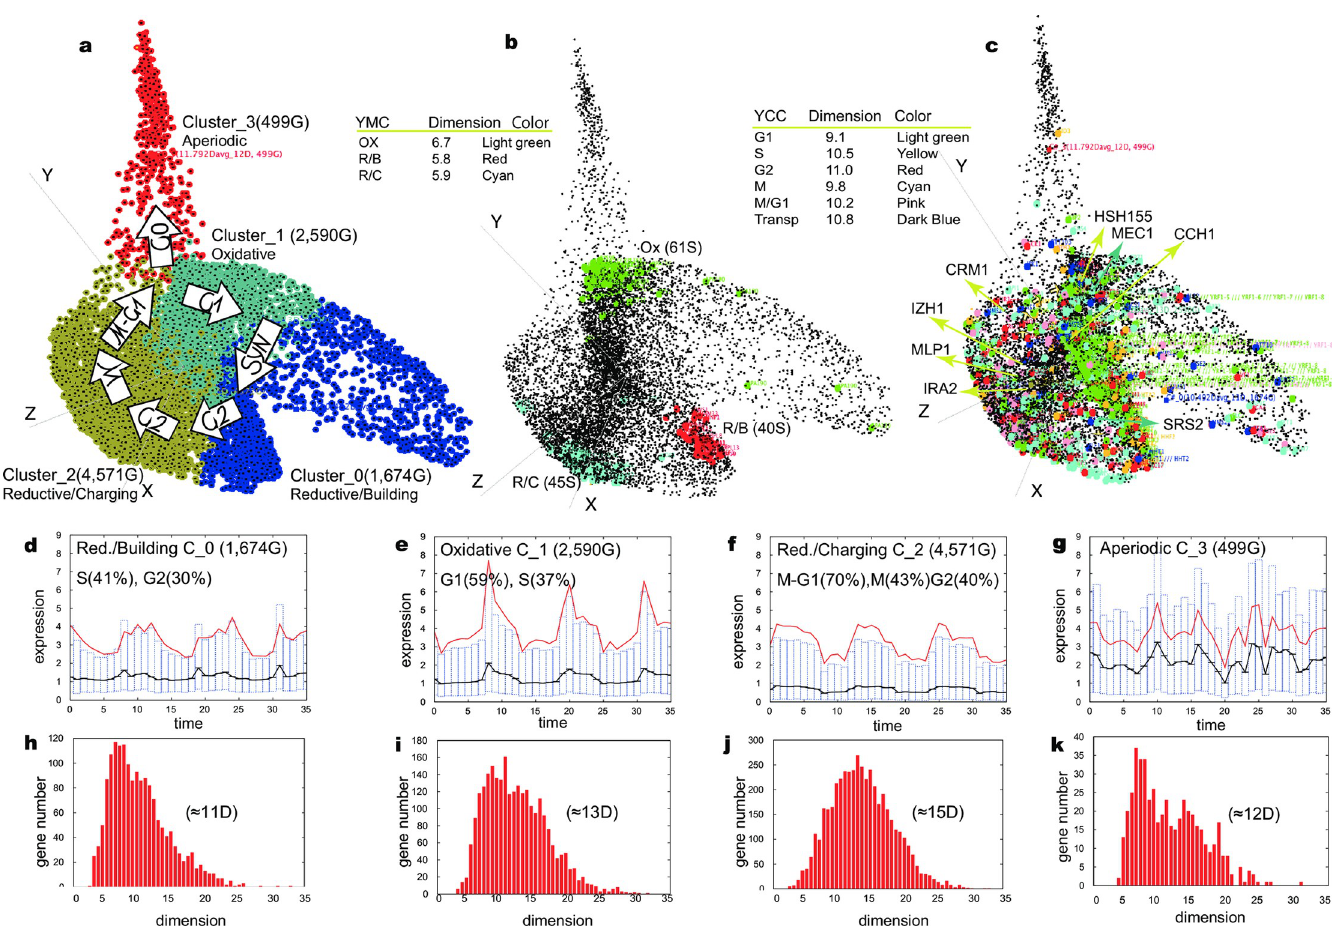
Fig 2. Clusters for the Yeast Metabolic Cycle (YMC) dataset (9,334G, 36 time points, 300 minutes): (a) Metabolic clusters aligned with the cell cycle. (b) YMC sentinel genes with average local dimension for each YMC phase in the table near the manifold. (c) YCC sentinels depicted by colored balls with a mean dimension for each YCC phase in the table near the manifold. Top Barycentre genes at a high local dimension are shown with respective dimensions in brackets and are pointed to with lines. (d)–(g) Cluster expression profiles, with candlesticks (solid red: average values; solid black: median values). Boxes indicate the Q25, Q50 (black), and Q75 quantiles. The x-axis shows time point tags, and Y-axis shows gene expression. (h)–(k) Dimension histograms of local dimensions (X-axes) and the number of genes (Y-axes) for respective clusters in (d)–(g). Local dimension scale of X-axes in (d)–(g) fits the scale of ambient space (X-axes) in (h)–(k).